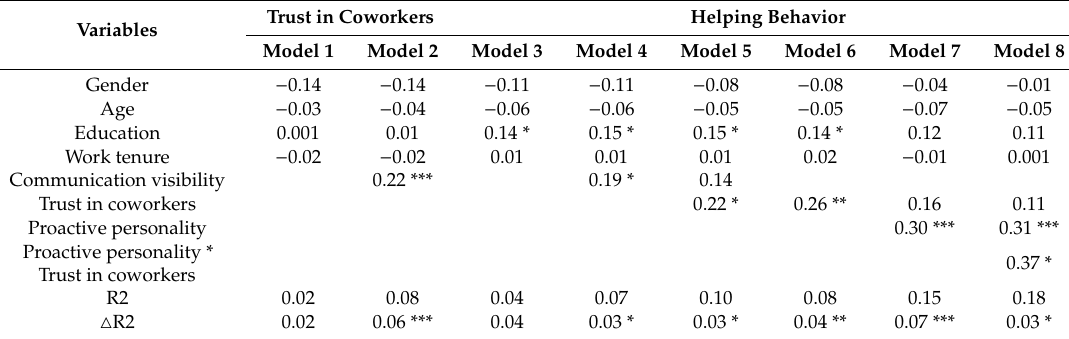
Table 4. Regression